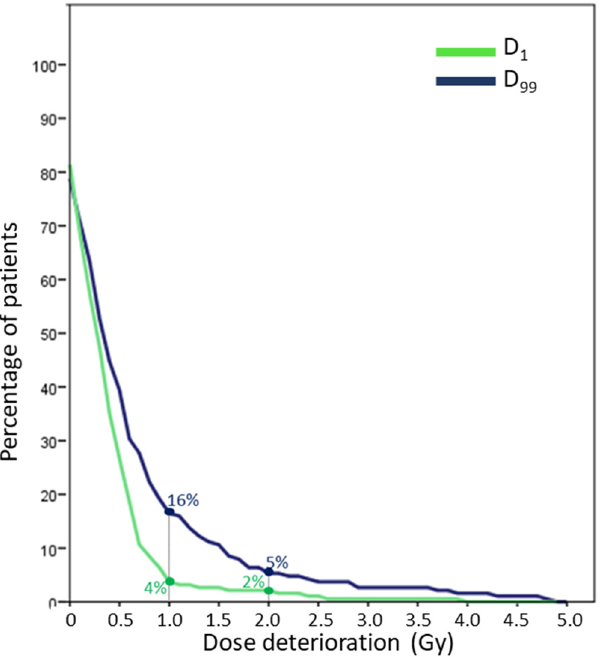
Figure 2. Incidence of the worst case absolute dose deterioration between accumulated ETV and planned PTV in any of the target volumes, both for over ‐ and under ‐ dose (D 1 and D 99 , respectively).